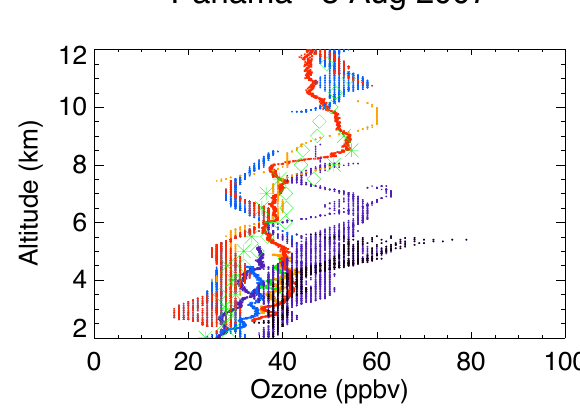
Fig. 6. Ozone profiles on 5 August 2007 in the Gulf of Panama region from sonde (thick colors), DC-8 DIAL (colored dots), and mean DC-8 in situ (green diamonds before 17:17UTC and green stars after 17:17UTC). See text for details.